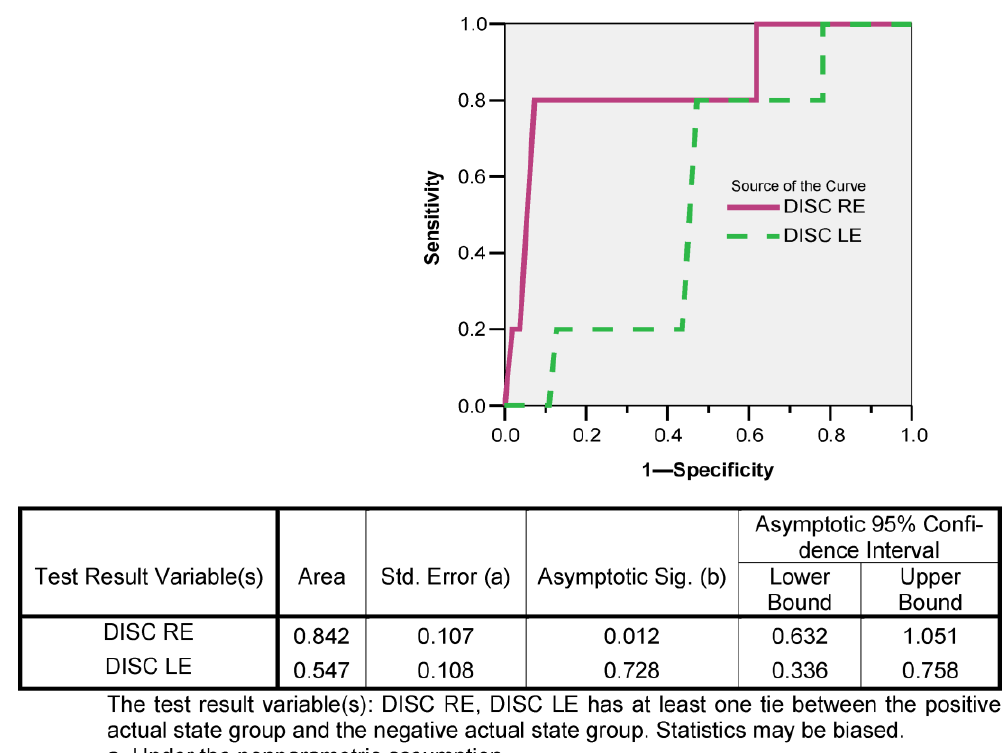
Figure 3. ROC Curve. Severe SAS dependent variable. Predictor of optic disk area. DISC RE and DISC LE represent the disc area measured by ocular computer tomography on each eye separately (right eye and left eye).